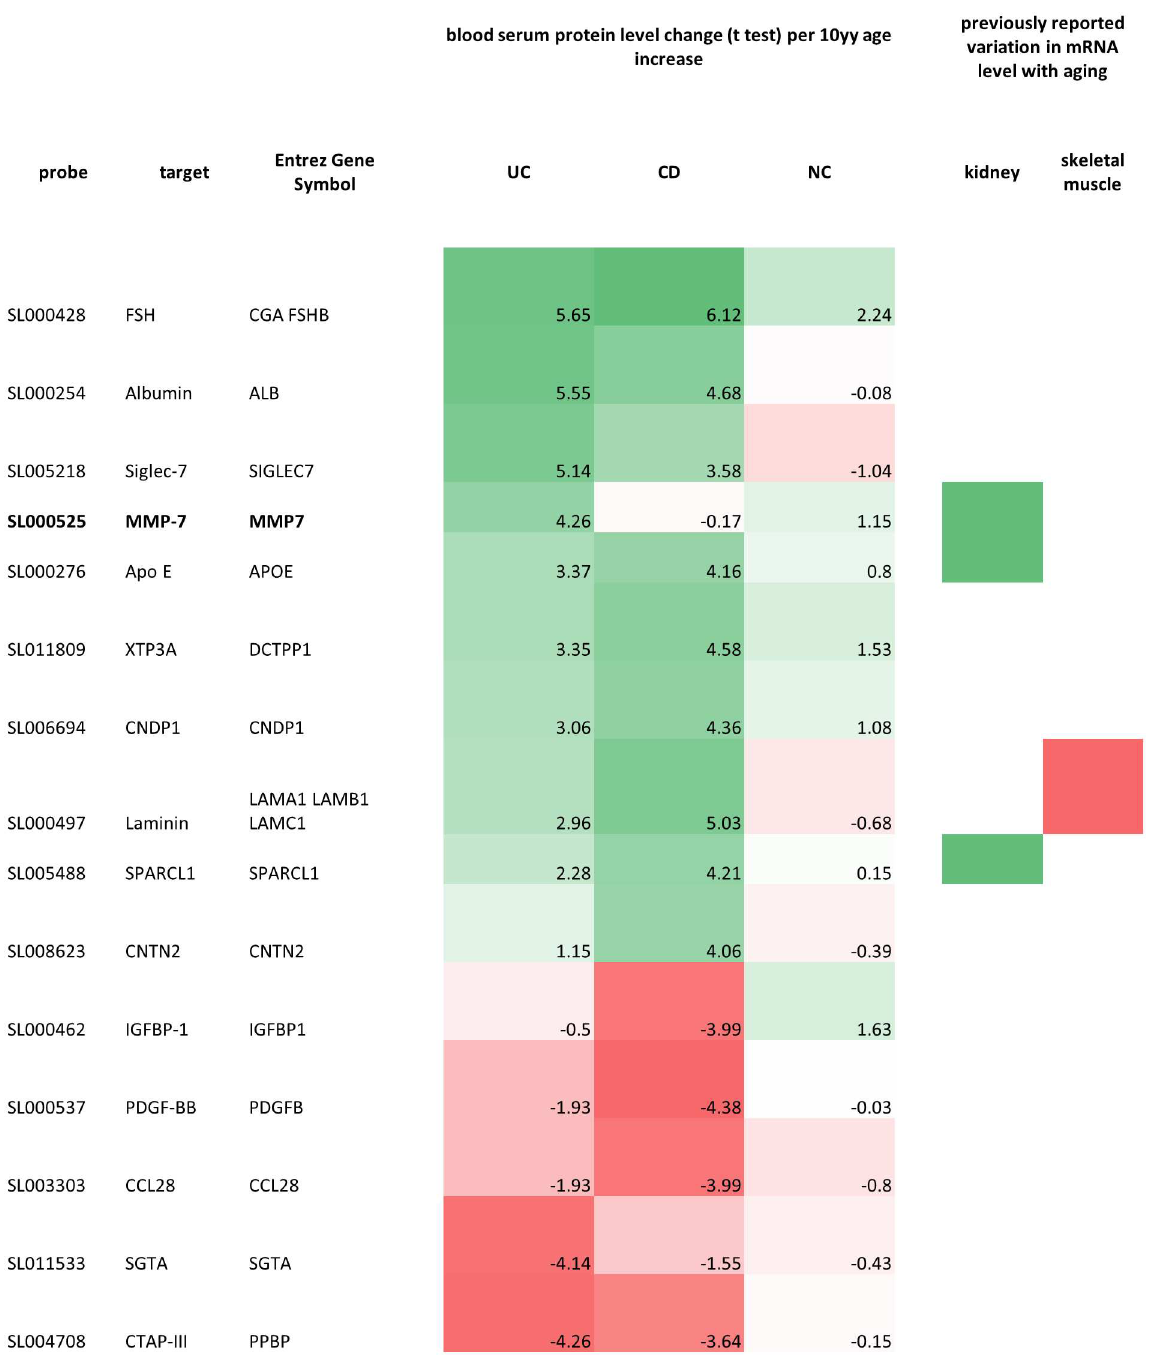
Fig 1. Heatmapof top significant age-related proteins. Includedin the heatmapare all microarrayprobes with pvalue (cid:20) 1E-4 in at least one cohort. The UC, CD and NC cells are color-codedaccordingto the Wald t-test of the age coefficient of the protein levels in each cohort, with the t test further reportedin each cell. The last 2 columnsreport previously known association of gene mRNA levels with age within different tissues. Shadesof green indicate increaseof protein or mRNA level with aging;shades of red indicate decreaseof protein or mRNA level with aging;the white color indicateslack of evidencein either